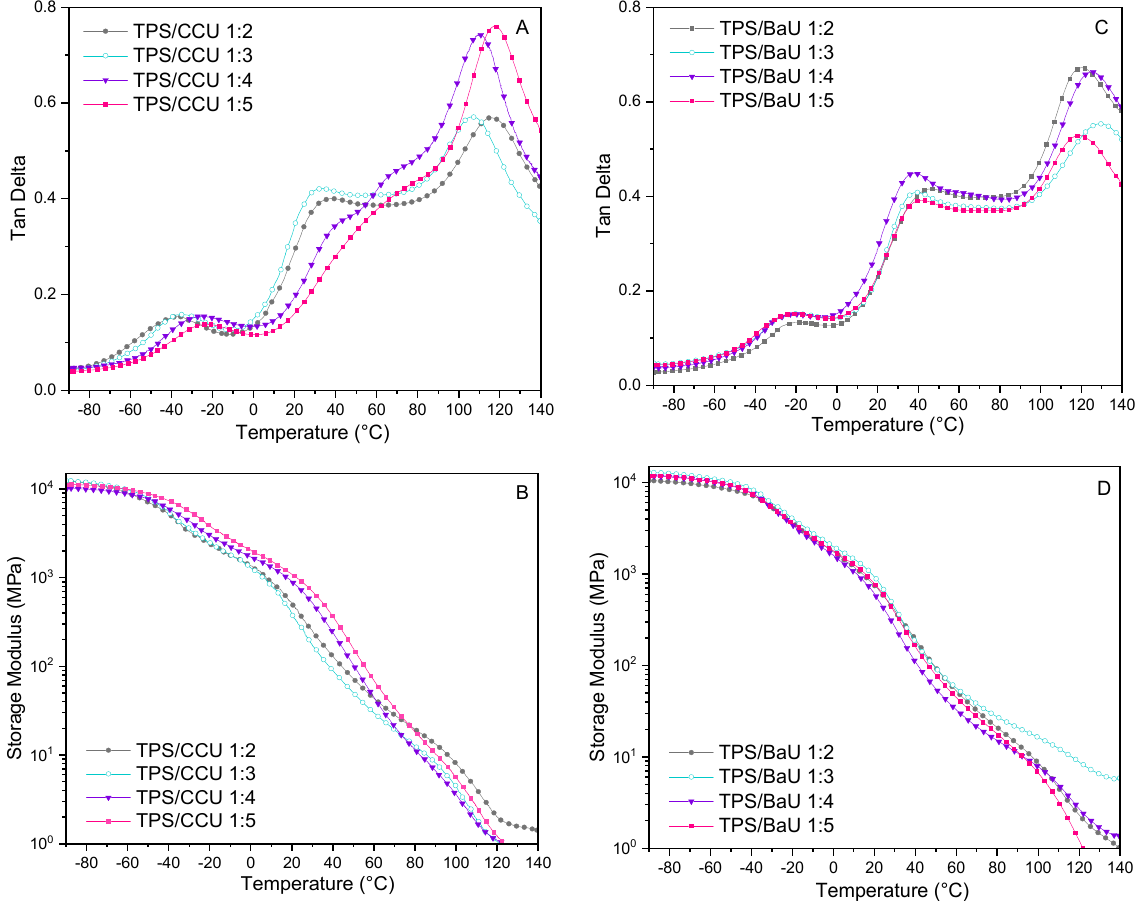
Figure 2. DMTA curves ( A ) Tan δ for TPS/CCU; ( B ) Tan δ for TPS/BaU and ( C ) Storage modulus − E’ for TPS/CCU; ( D ) Storage modulus − E’ for TPS/CCU; The analysis was performed on thermocompressed TPS films.